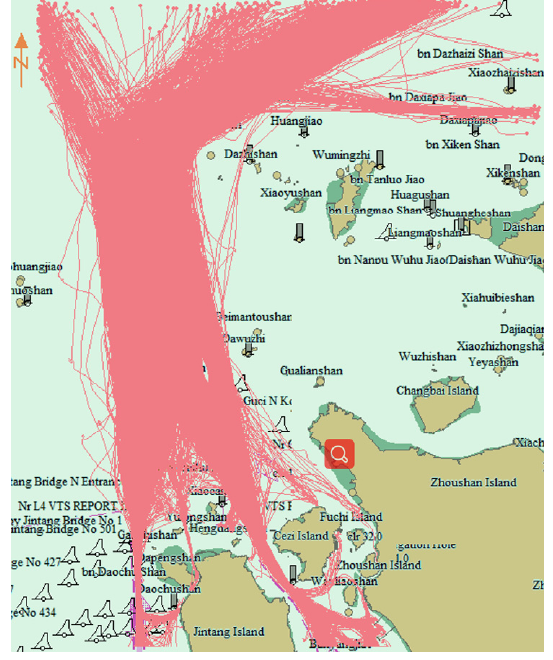
Figure 15. Independent trajectory merging result without deleting expired trajectories.